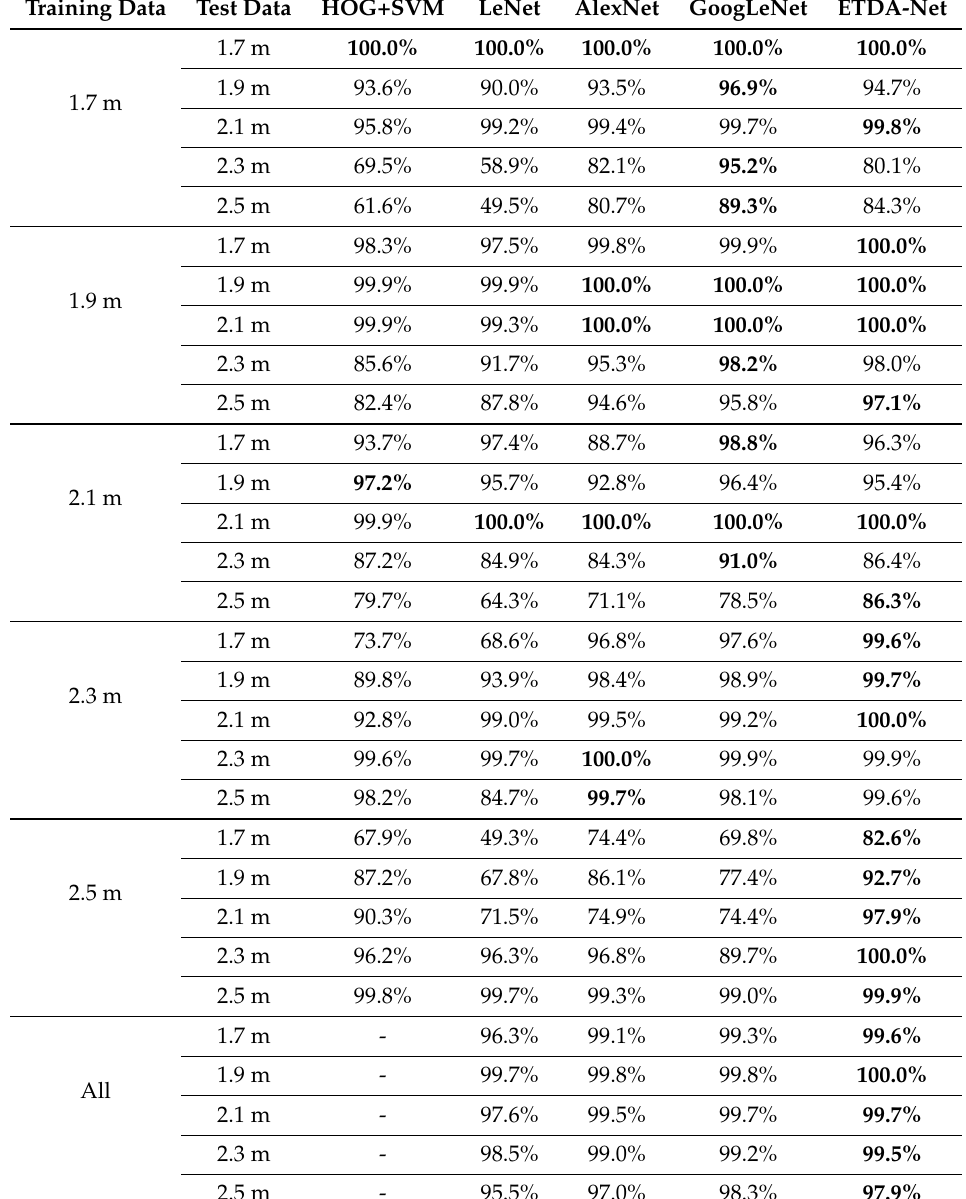
Table 6. Experimental results from accuracy